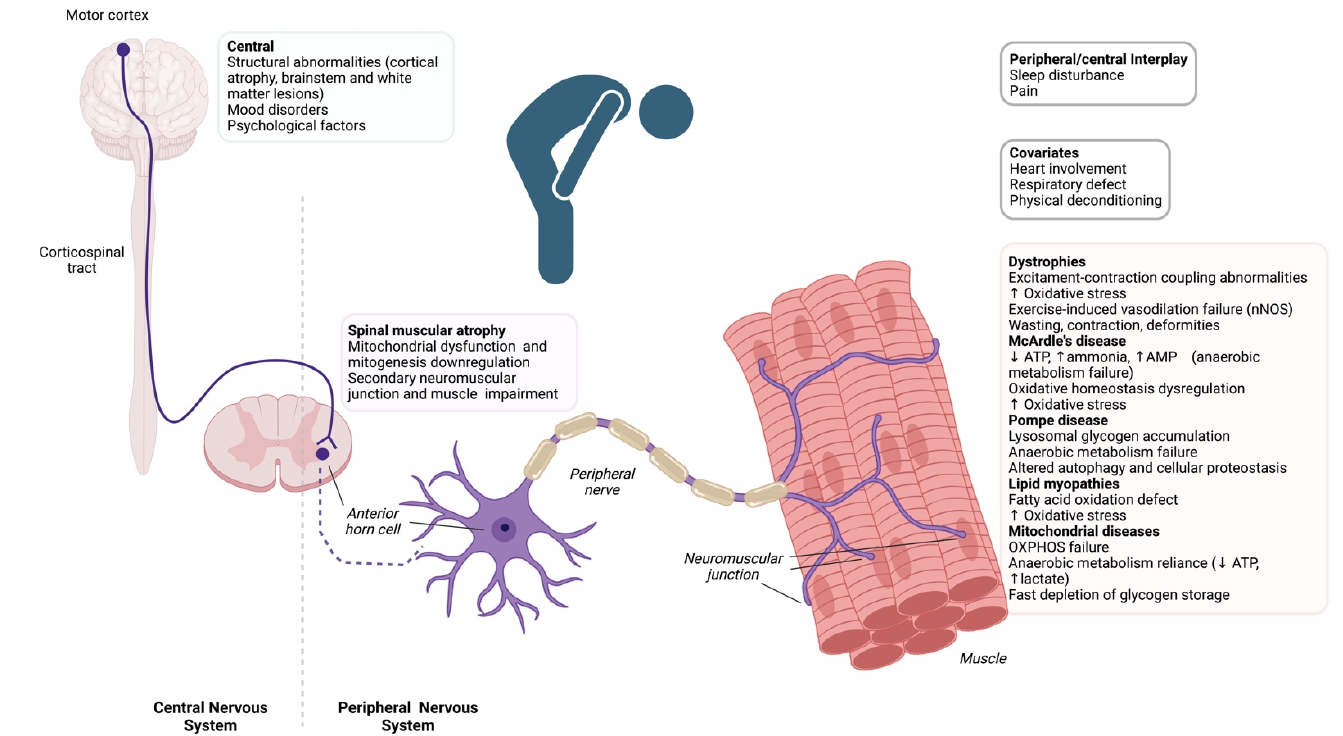
Figure 1. Overview on pathophysiological mechanisms involved in fatigue and exercise intolerance in neuromuscular disorders.